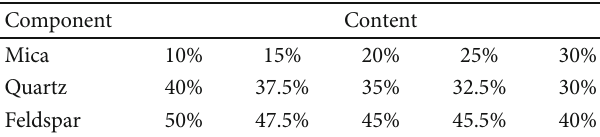
Figure 3: The construction process of the component distribution of the model specimen. Table 1: The content of di ff erent components in the generated